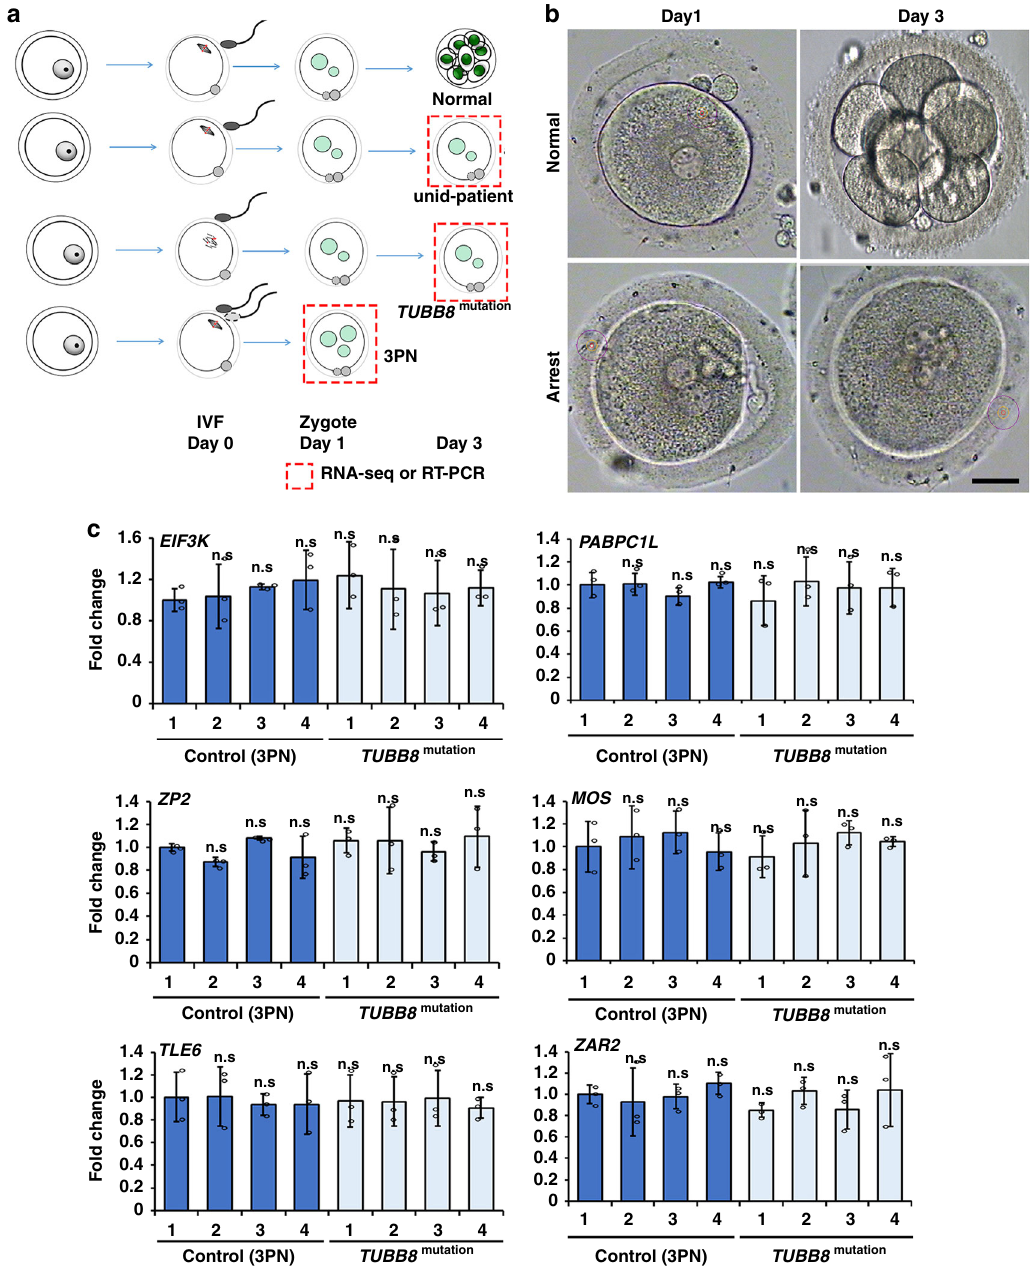
Fig. 5 TUBB8 mutation did not affect M-decay in human zygotes. a A illustration of human embryo collection for RT-qPCR or RNA-seq. Oocytes that were derived from unidenti fi ed or TUBB8 -mutated patients were in vitro fertilized and cultured for 3 days before RNA isolation. b Representative images showing morphologically normal and 1-cell stage-arrested embryos at 3 days after IVF. Scale bars = 40 µ m. All observed normal ( n = 4) and arrested embryos ( n = 15) looked like this in three independently repeated observations. c RT-qPCR results showing the relative levels of M-decay transcripts in the 3PN zygotes 1 day after IVF and arrested zygotes of TUBB8 -mutated patients 3 days after IVF. 1 – 4 represent embryos from different women. Data are presented as mean values ± SEM. n.s. non-signi fi cant by one-way ANOVA. n = 3 independent BTG4 and CCR4-NOT may also participate in the M-decay pathway of human embryos. 8-cell stage-arrested human embryos. Morphologically normal embryos at the 1-cell and 8-cell stages were collected. The 8-cell arrested embryos at day 5 after IVF were separately collected from six patients who experienced repeated developmental failure of preimplantation embryos after IVF (Fig. 8a, b). Individual normal and arrested embryos were subjected to single-embryo RNA-seq analyses, and the gene expression levels were assessed by FPKM. normal embryos should develop into blastocysts 5 days after IVF.